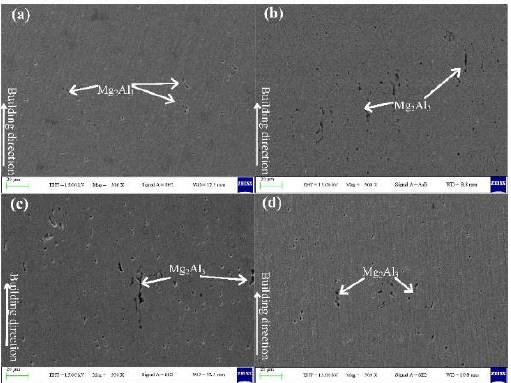
Figure 13. Scanning electron microscope (SEM) of the β (Mg 2 Al 3 ) phase in thin walls deposited by the